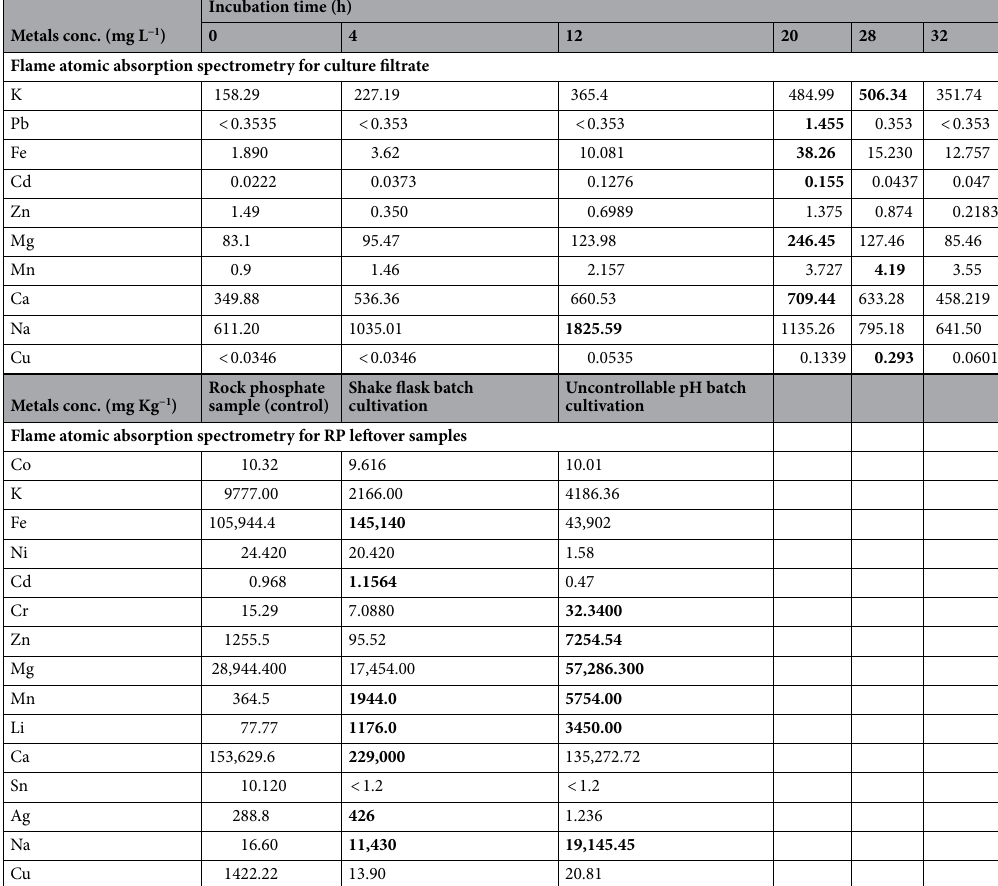
Table 6. Flame atomic absorption spectrometry for heavy metals analysis of culture filtrate samples during shake-flask batch cultivation and RP leftover samples during shake-flask, and uncontrollable pH batch cultivation system. Significant values are in